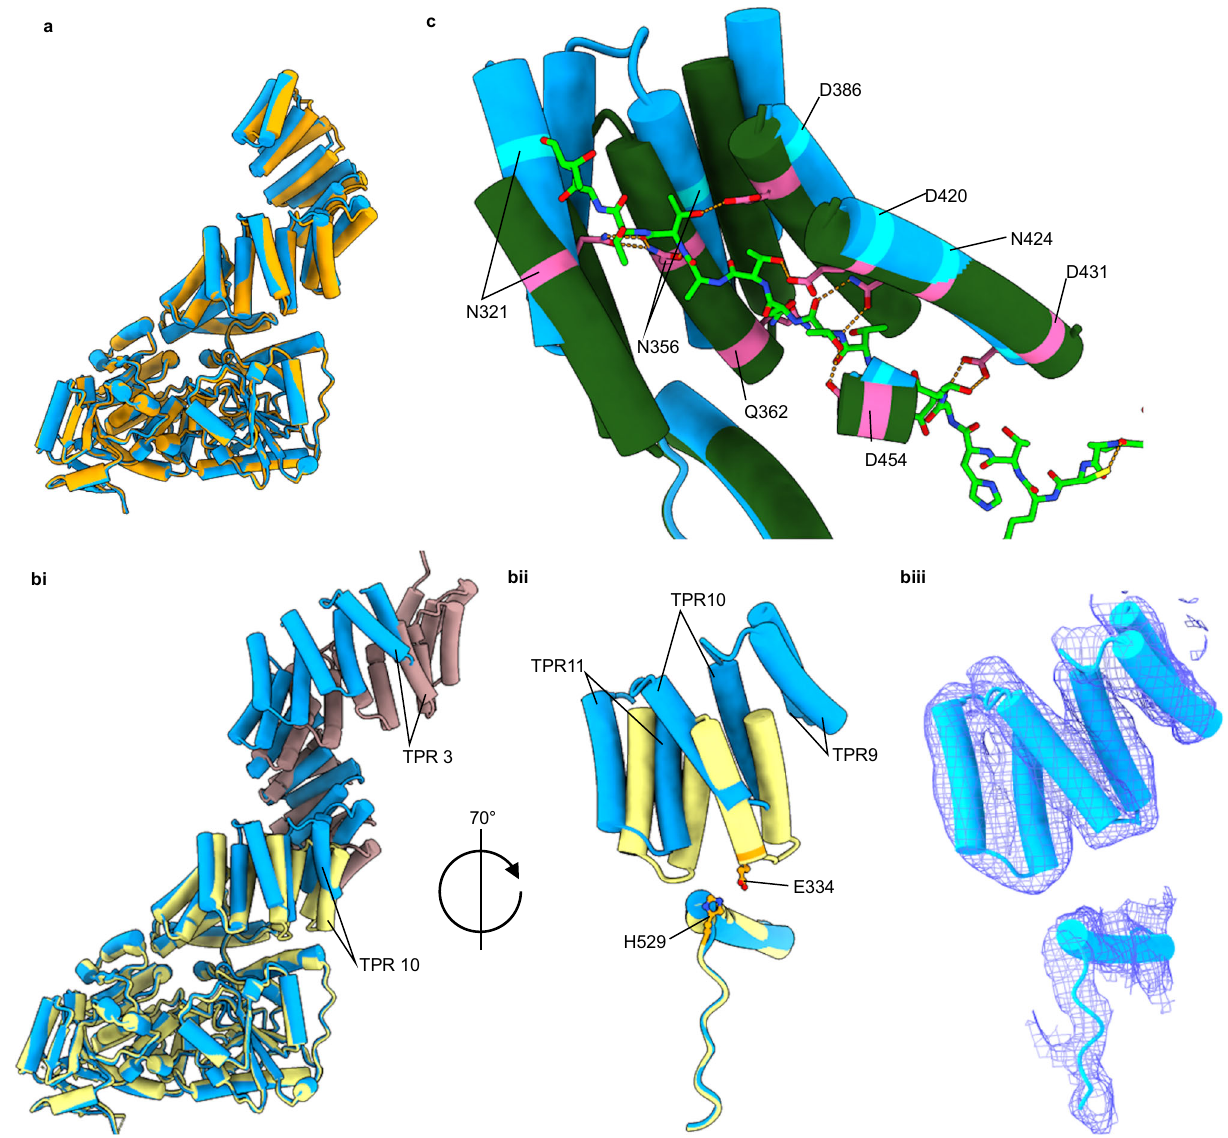
Fig. 4 Comparison of cryo-EM model to crystal structures. a Superimposition of chain A (blue) onto chain B (orange) of the 5.3 Å structure demonstrates the distortion of the twofold symmetry. bi Comparison of the cryo-EM model (chain A, blue) to the OGT/UDP X-ray structure with the TPR 11.5 X-ray structure (chain A) superimposed (PDB: 3PE3, yellow. PDB: 1W3B, pink). Residues 544 – 1028 were used for superimposition. bii TPRs 9 – 11 and their relative position to residues 505 – 538 of catalytic region. Residues suggested to promote TPR 10 anchoring to the catalytic region depicted in orange. biii Cryo-EM map into which the TPRs and residues 505 – 538 were modelled. c Comparison of cryo-EM model (chain A) to the OGT/UDP/HCF-1 peptide ternary complex (PDB: 4N3C, green) 9 . Residues 544 – 1028 were superimposed. Hydrogen bonding interactions depicted as dashed orange and co-ordinate interactions with both protein partners and centrifugation at 41,700 × g for 1h. Lysate was passed over 2× 1ml HisTrap FF columns (GE Healthcare) equilibrated in buffer A. Protein was eluted by a stepwise substrates.